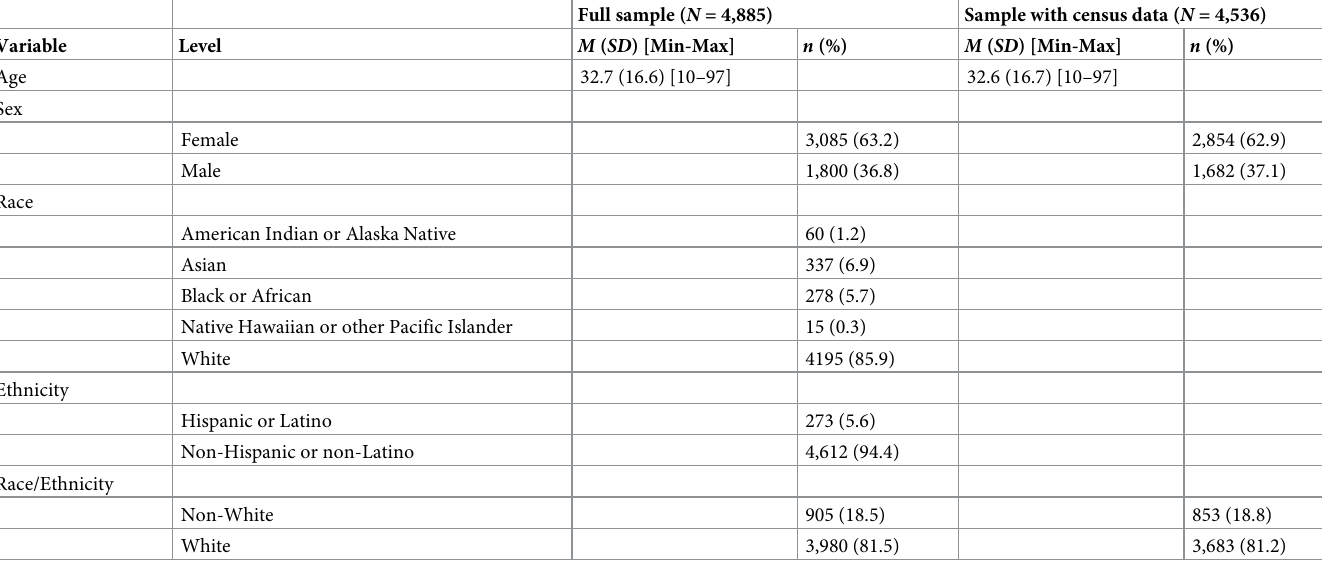
Table 1. Participant characteristics.